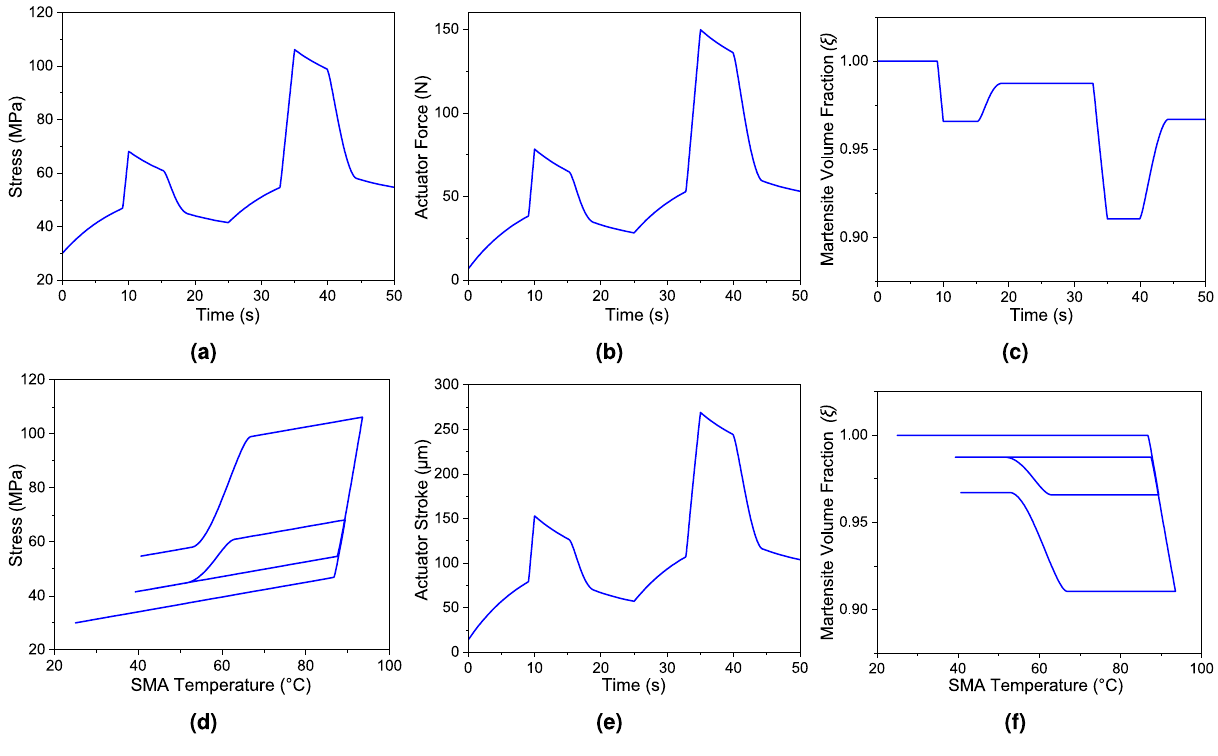
Figure 4. Under the input condition of 7 V for two cycles, analytical findings for the distribution of various parameters are displayed (10 s heating and 15 s cooling cycle). While ( a – c ) and ( e ) depicts a temporal distribution, on the other hand ( d ) and ( f ) illustrates distribution over temperature. For the concerned input condition, the maximum stress observed was 106 MPa (which was less than 345 MPa, the yield strength of the wire) , with a force of 150 N and a maximum displacement of 270 µ m, and the minimum martensite volume fraction was 0.91. On the other hand, the variation of stress and variation of martensite volume fraction with temperature resembles the hysteresis property.